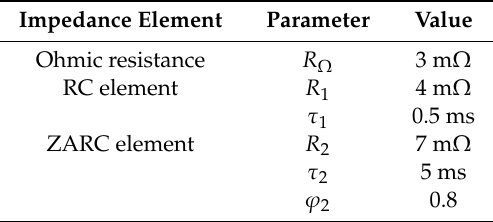
Table 2. Model parameter values of the impedance simulation of series connection of an ohmic resistance, an RC element, and a ZARC